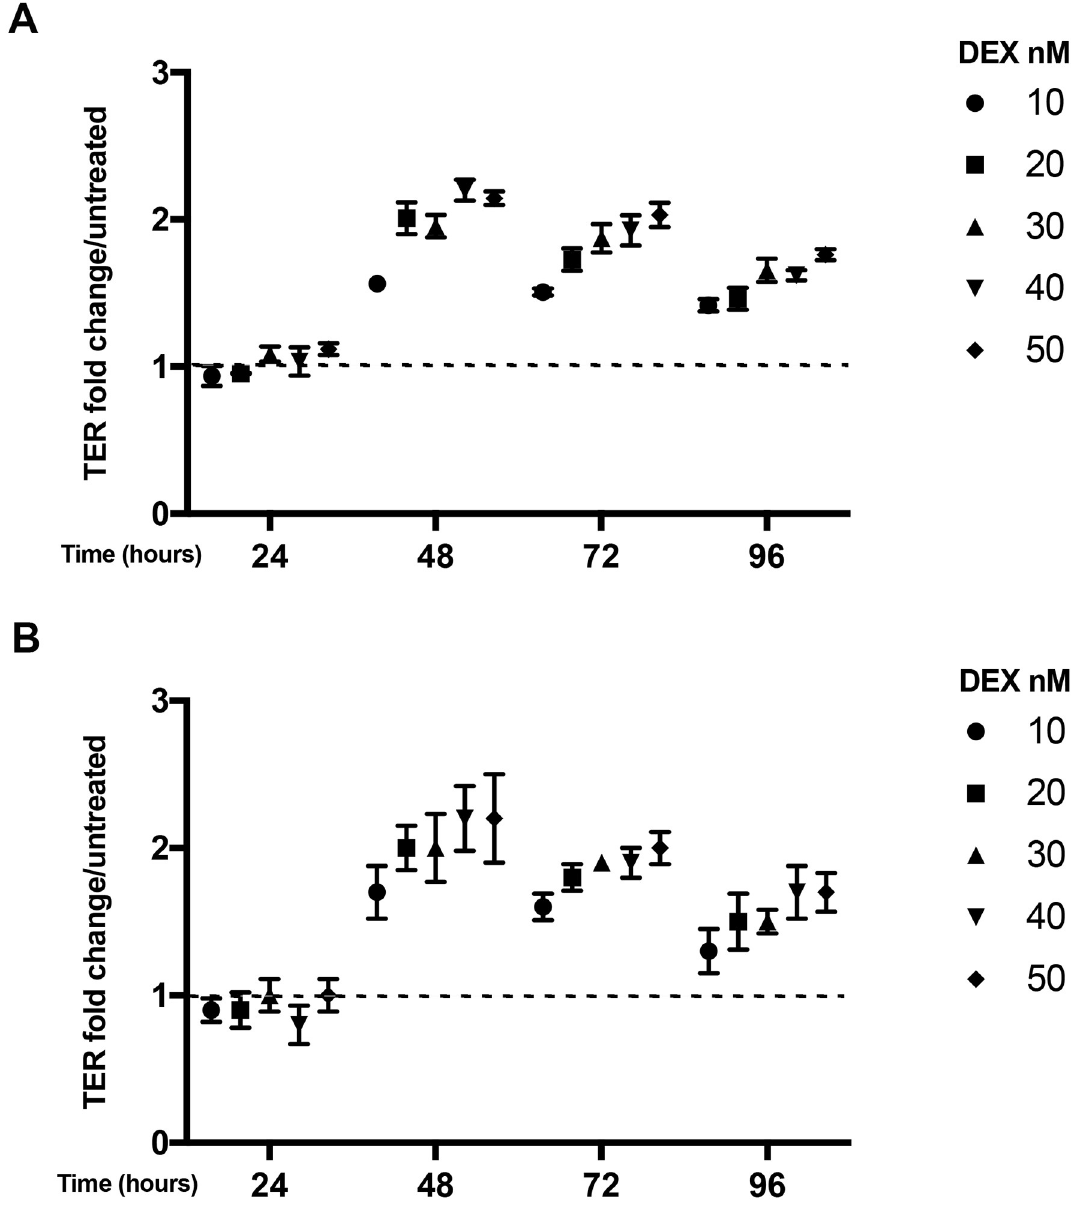
were in the range of 359–563 ohms � cm 2 for PLLA and 455–721 ohms � cm 2 for PET membranes. TER was calculated as ohms � cm 2 and corrected for the background value detected in an empty cell culture insert containing medium alone (PET = 54.5 ohms � cm 2 and PLLA = 99 ohms � cm 2 ). Data are mean ± SD, n = 3 independent experiments each performed in